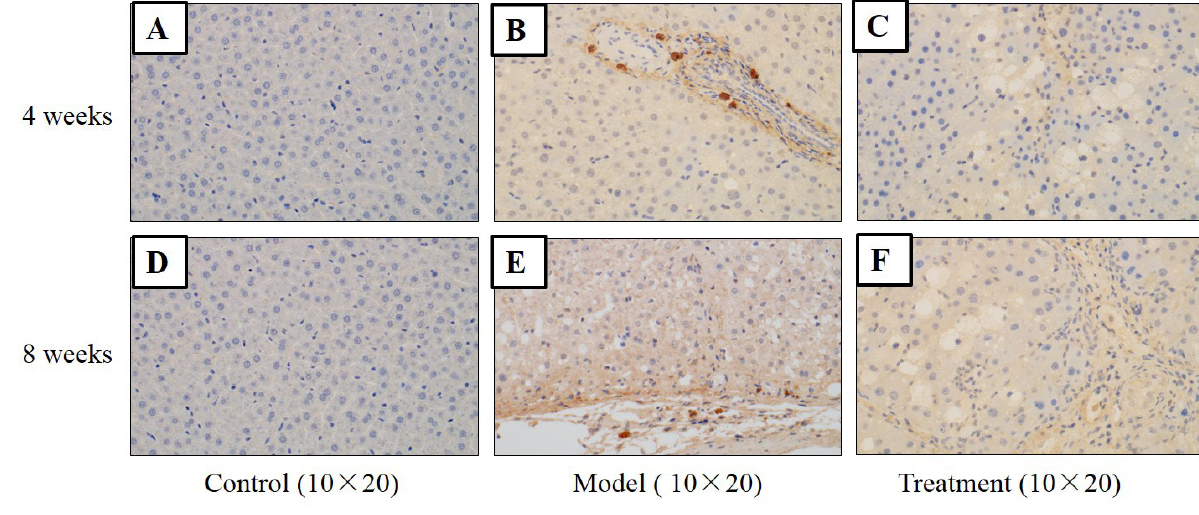
-induced group, and DHZCP-treated group at 4